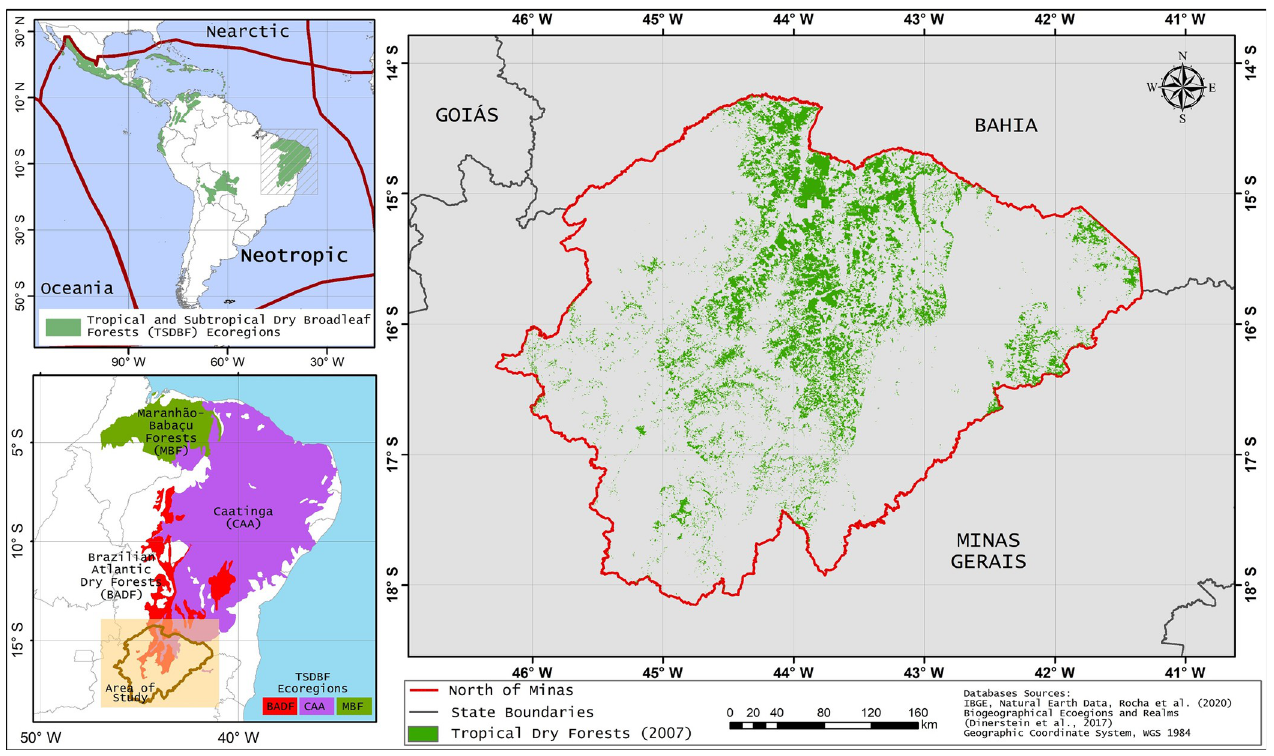
Fig 1. Location of TDFs in the north of Minas Gerais, Brazil, South